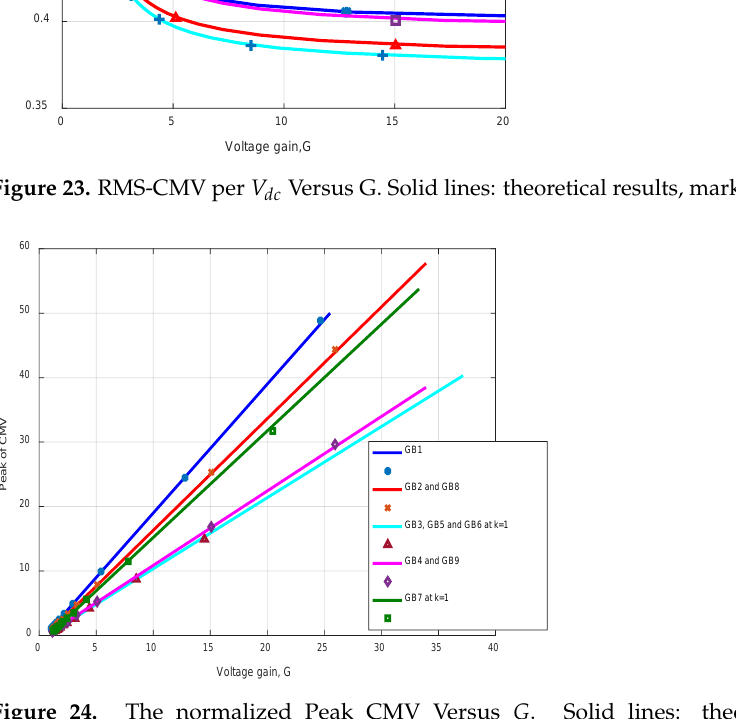
. Solid lines: theoretical results, marks: simulation 𝑮𝑮